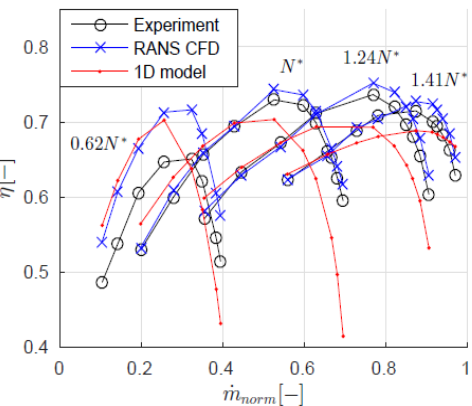
Figure 2. Comparison on the isentropic efficiency in the experiment including the Reynolds-averaged Navier–Stokes (RANS) computational fluid dynamics (CFD) and 1D model.